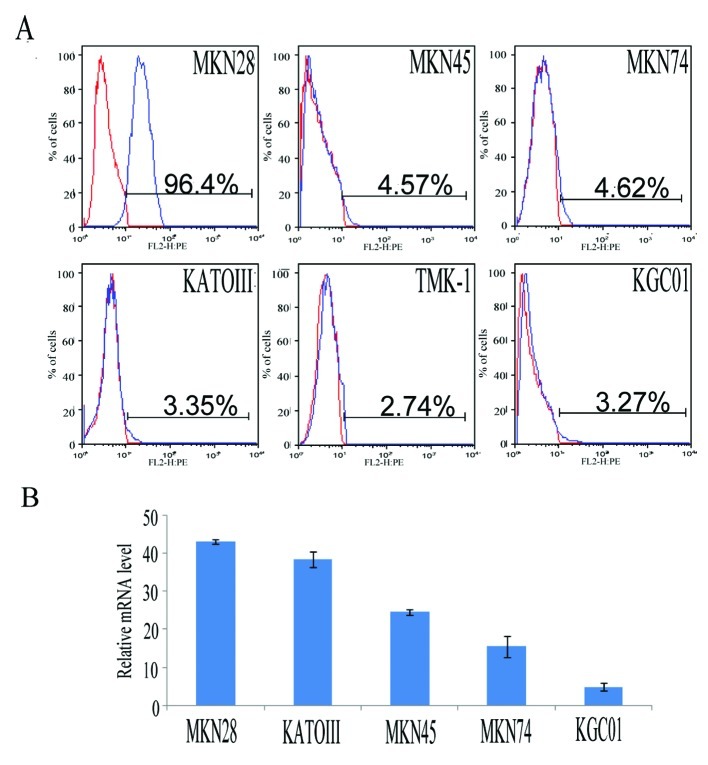
Analysis of EGFR expression in human GC cell lines. (A) Flow cytometric analysis of EGFR expression in human GC cell lines. Cells were treated with monoclonal antibodies against human EGFR. Expression levels were estimated by the intensity of fluorescence with phycoerythrin (PE) in the samples (red histogram, isotype control; blue histogram, cetuximab). (B) Relative mRNA expression of EGFR in GC cell lines was determined using a quantitative real-time RT-PCR amplification analysis. Results were analyzed using the relative quantification (ΔΔCT) method.